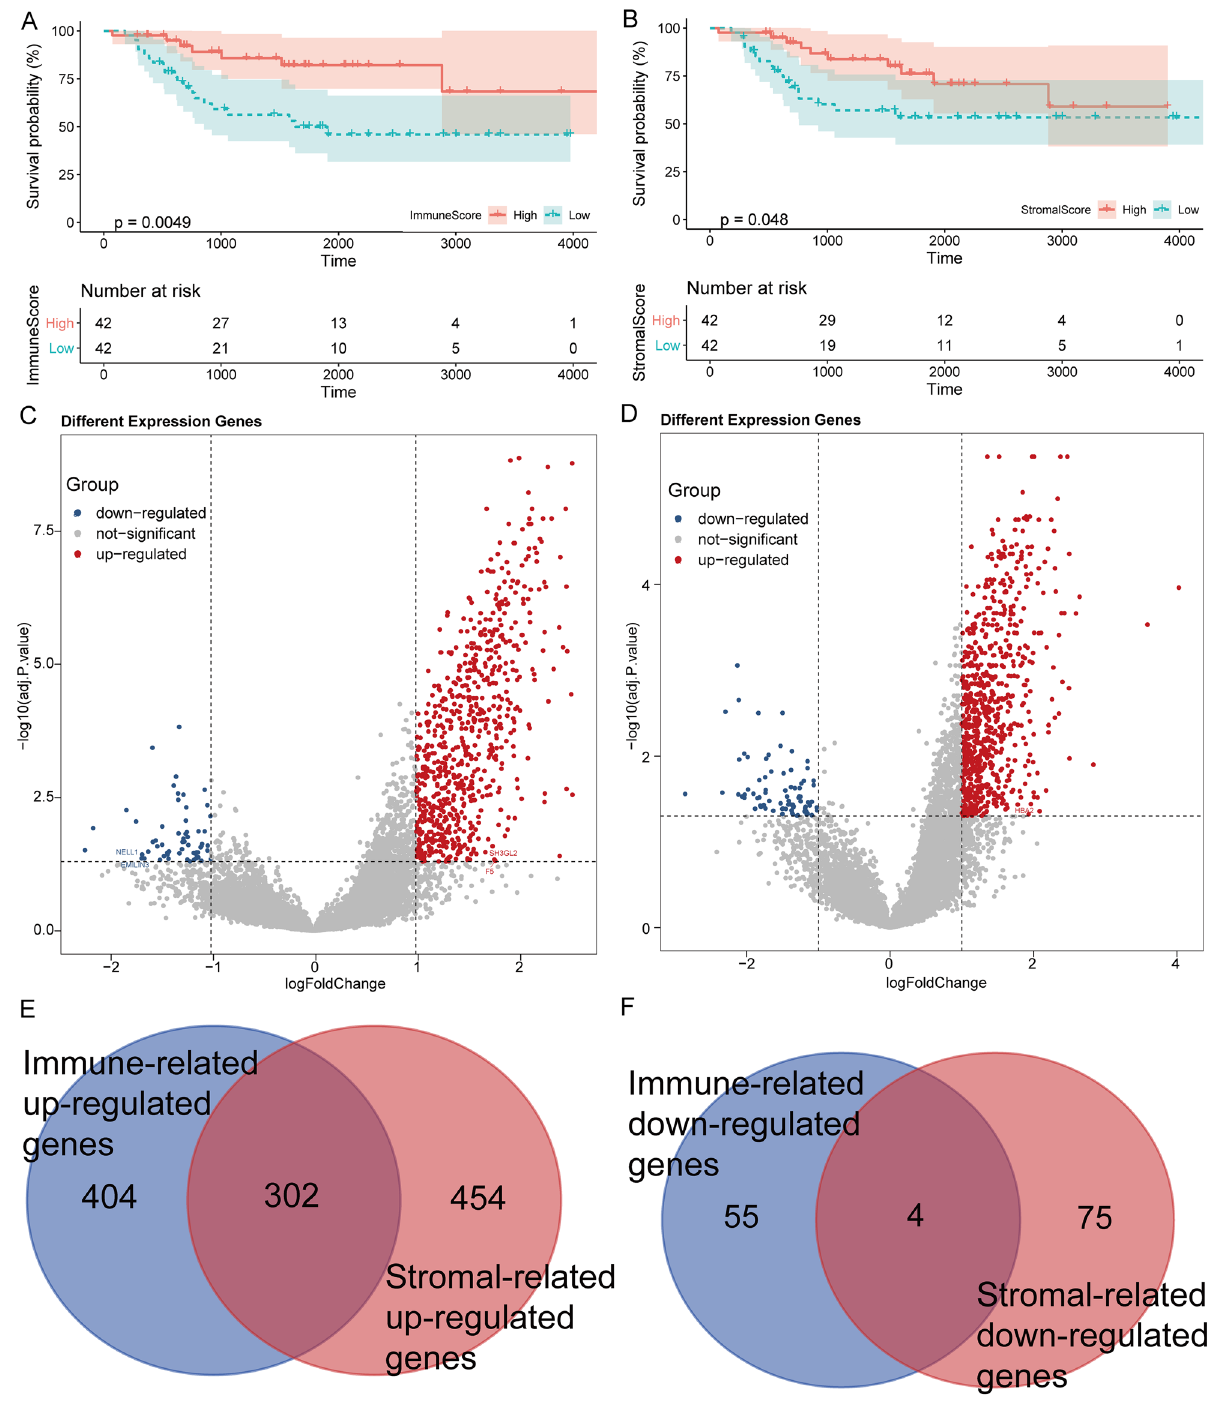
Figure 1. Immune-related DEGs identification. ( A ) Kaplan–Meier survival analysis for osteosarcoma patients grouped into the high or low score in immune score determined by the comparison with the median. p = 0.0049 by log-rank test. ( B ) Kaplan–Meier survival curve for the stromal score with p = 0.048 by log-rank test. ( C ) Volcano plots for DEGs were generated by comparison of the high score group vs. the low score group in the immune score. ( D ) Volcano plots for DEGs were generated by comparison of the high score group vs. the low score group in the stromal score. ( E , F ) Venn plots showing common up-regulated and down-regulated DEGs shared by immune score and stromal